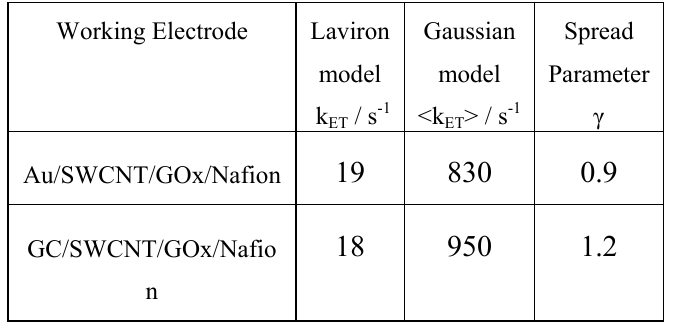
Figure 23. Typical double logarithmic plots calculated for various values of the Gaussian spread parameter γ . Table 2. Analysis of chronoamperometric transients via the simple Laviron model and via the Gaussian spread model.